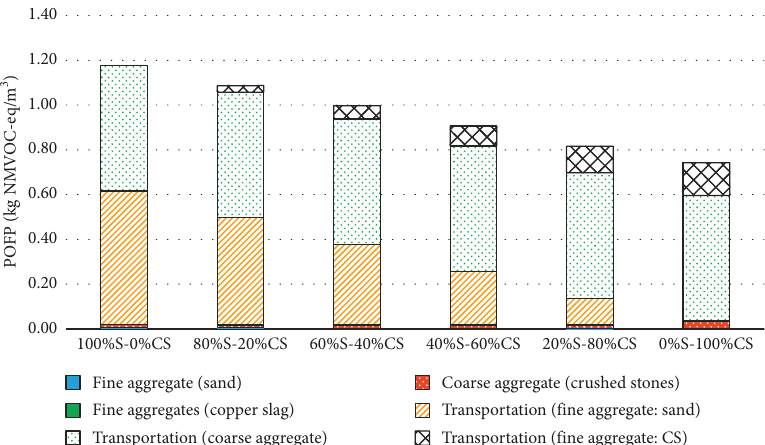
Figure 7: Distribution of POFP results for concrete aggregates (cement impacts are excluded), GreenConcrete LCA tool [3].